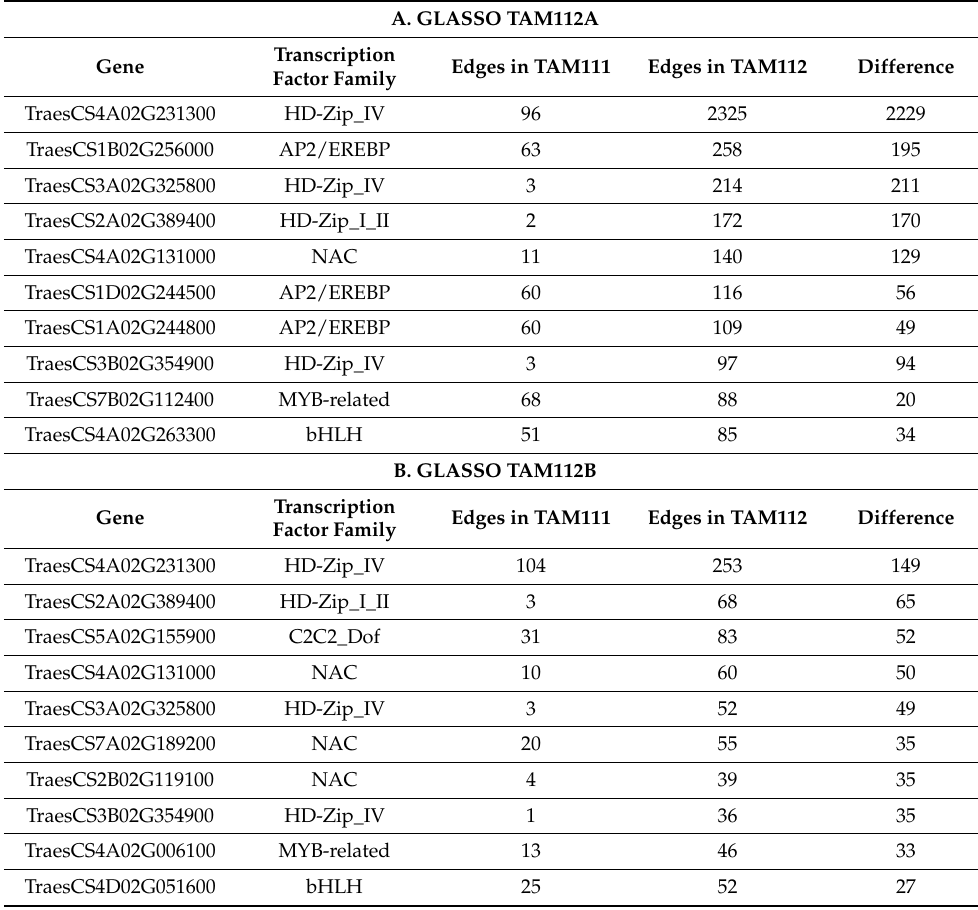
Table 3. ( A , B ) Top 10 transcription factors identified from GLASSO using the module groups expressed higher in TAM112. ( A , B ) represents regions from TAM112 in Figure S4. Lists are sorted by the difference in the number of edges between the two